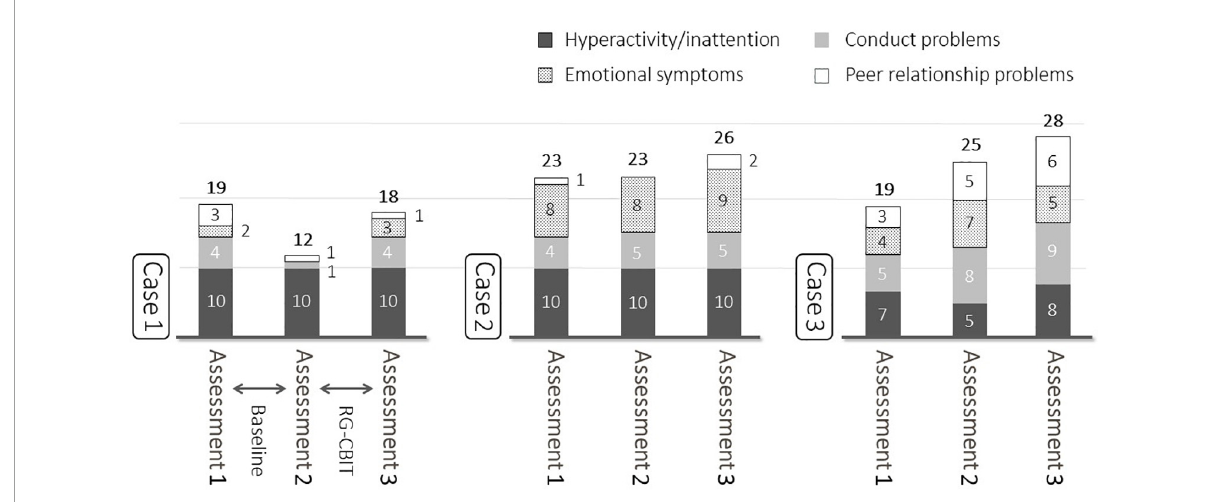
FIGURE3 Baseline and post-treatment SDQ. After the intervention, the total SDQ scores increased by 6, 3, and 3 points for cases 1, 2, and 3,